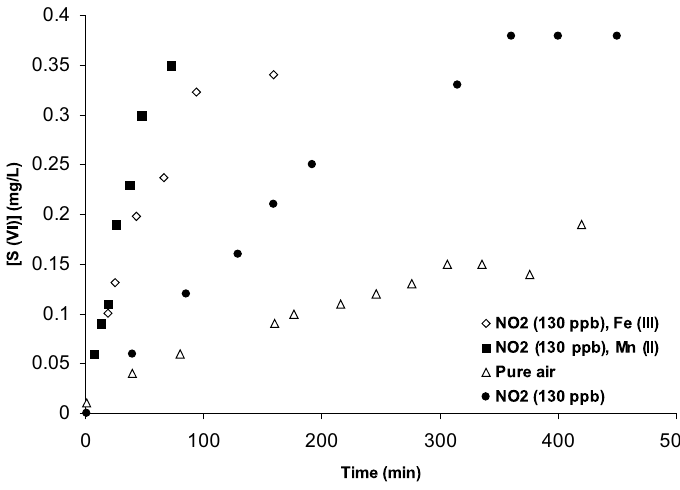
Fig. 6 – Time dependence of [S(VI)] for S(IV) oxidation, [S(IV)] ◦ = 8 mg/L, T = 22 ◦ C, pH =